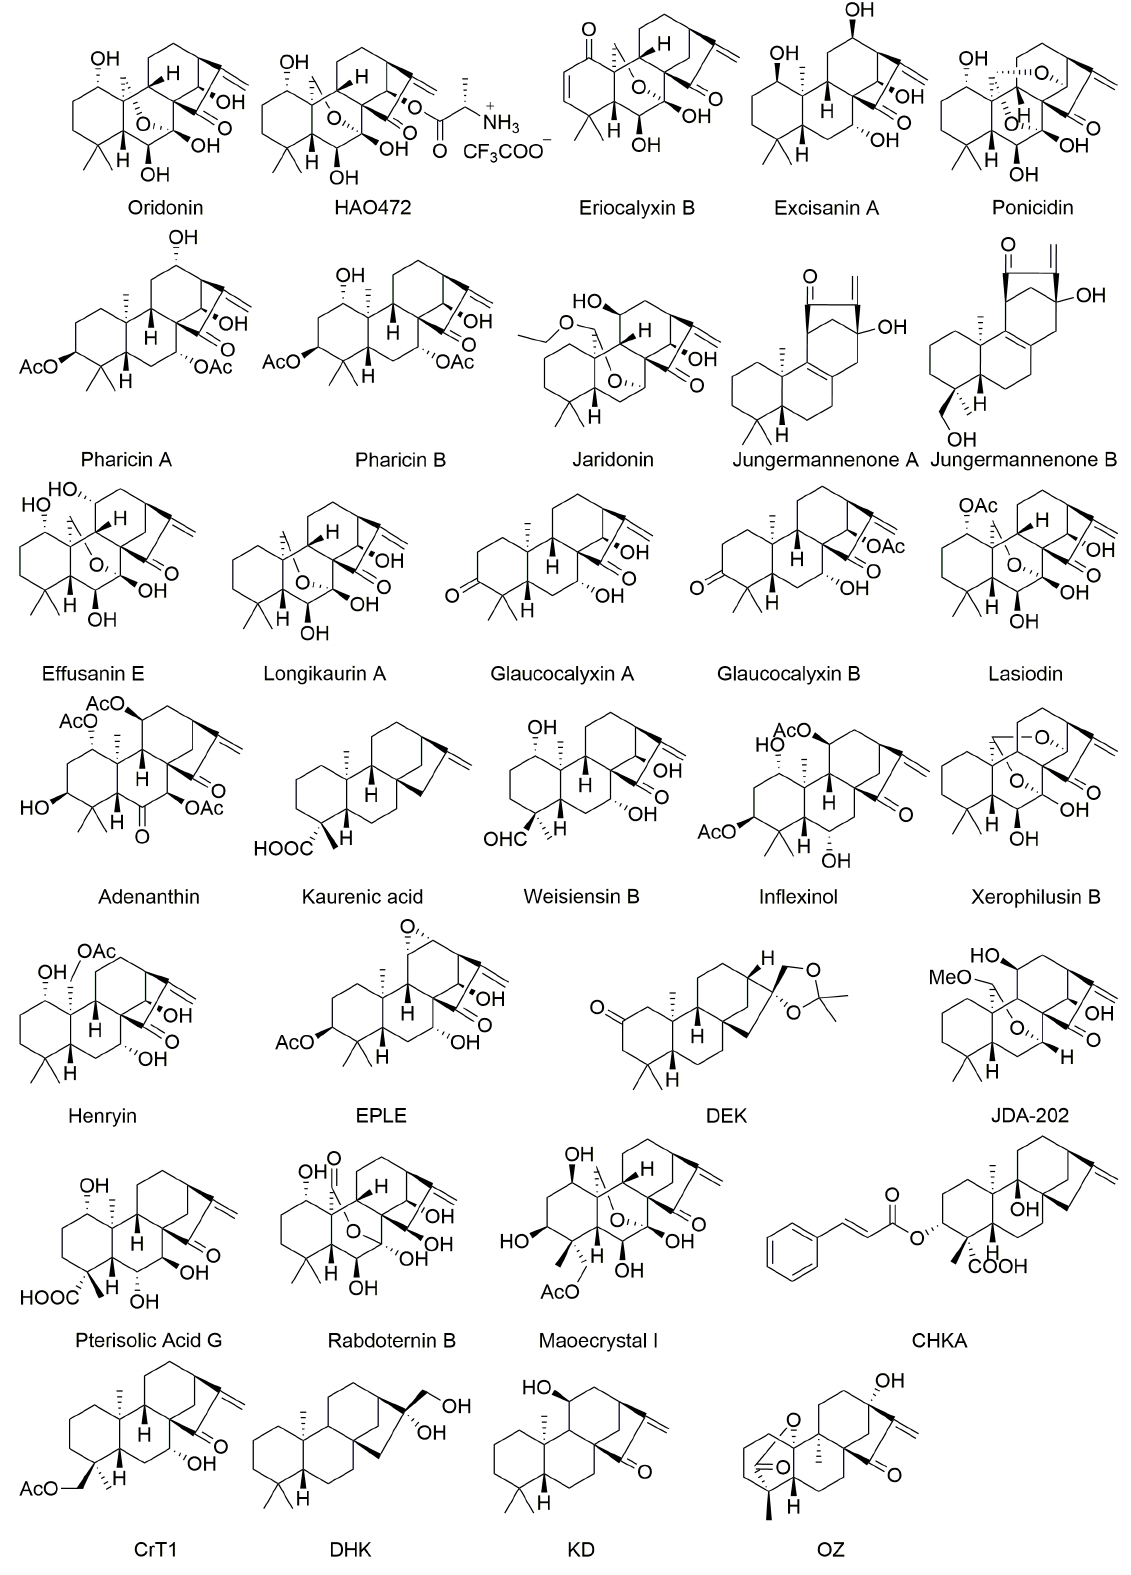
Figure 2. Structures of plant-derived anticancer ent -kaurane diterpenoids. 2.26. Ent-11 α -hydroxy-16-kauren-15-one